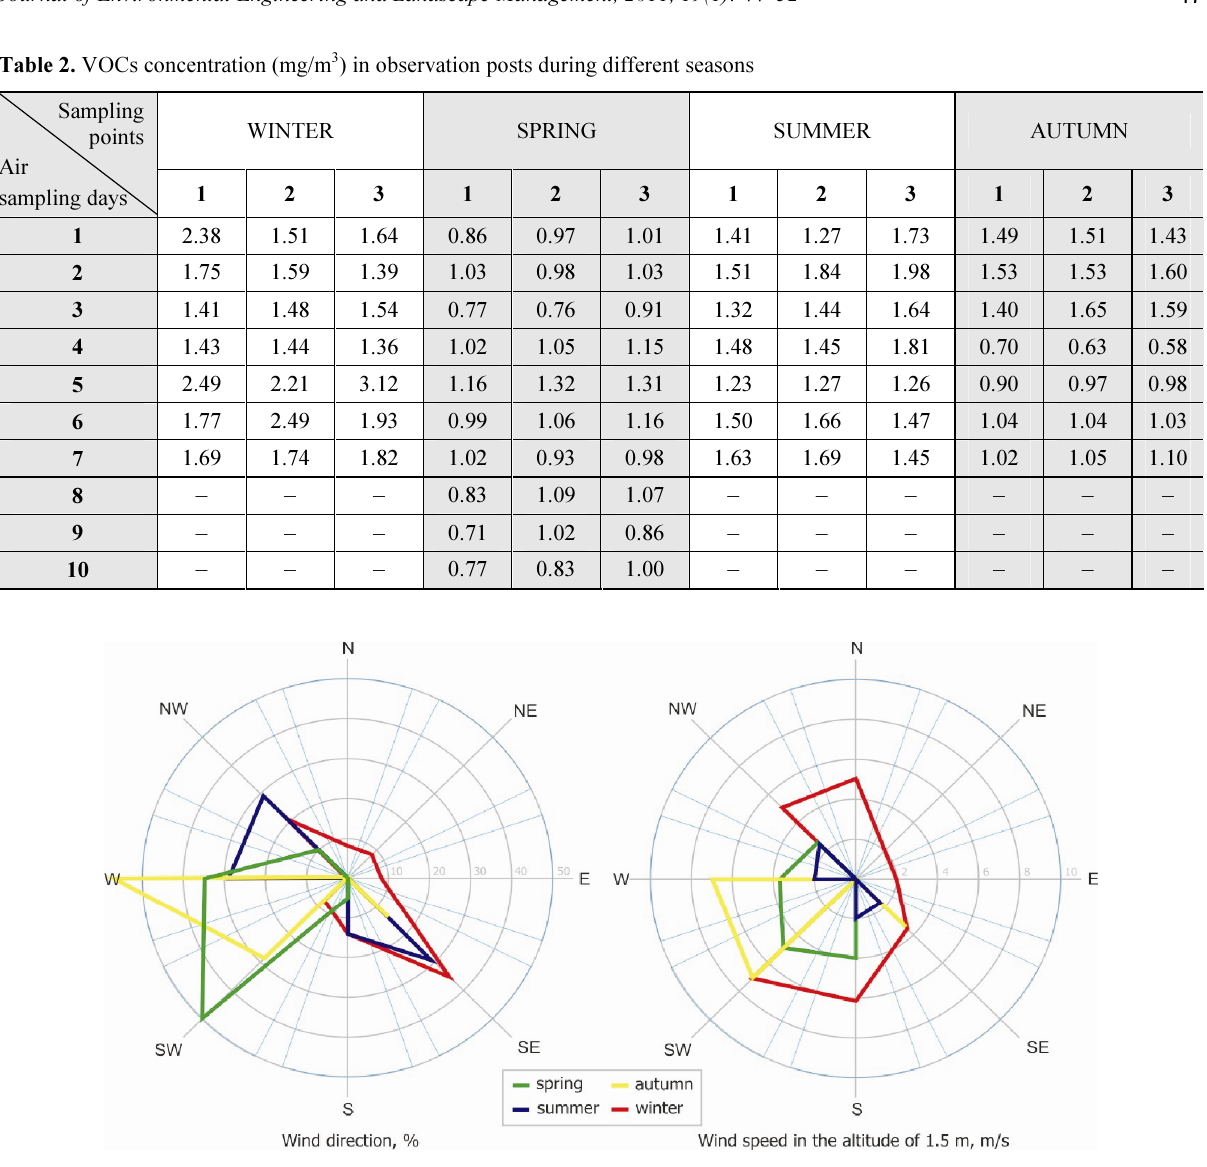
Table 2. VOCs concentration (mg/m